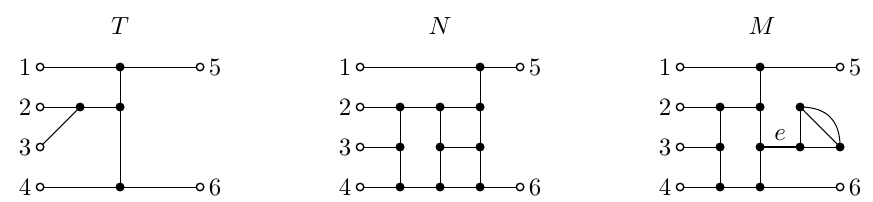
Figure 2: An unrooted, binary phylogenetic tree T ∈ u T and an unrooted, binary 6 proper phylogenetic network N ∈ u N . The unrooted, binary phylogenetic network M is 6 improper since the cut-edge e does not lie on a path that connects two leaves. An edge of a network N is an external edge if it is incident to a leaf, and an internal edge otherwise. A cherry { a, b } of N is a pair of leaves a and b in N that are adjacent to the same vertex. For example, each network in Figure 2 contains the cherry { 1 , 5 }